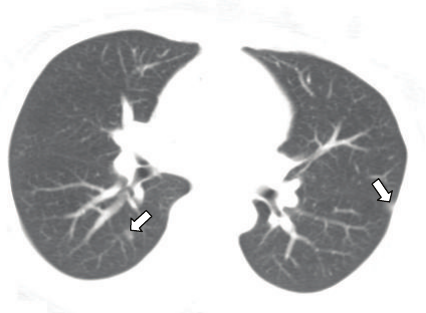
Figure 2: Color Doppler US image demonstrates vascularity in the echogenic mass with extensive vascularity surrounding the mass.